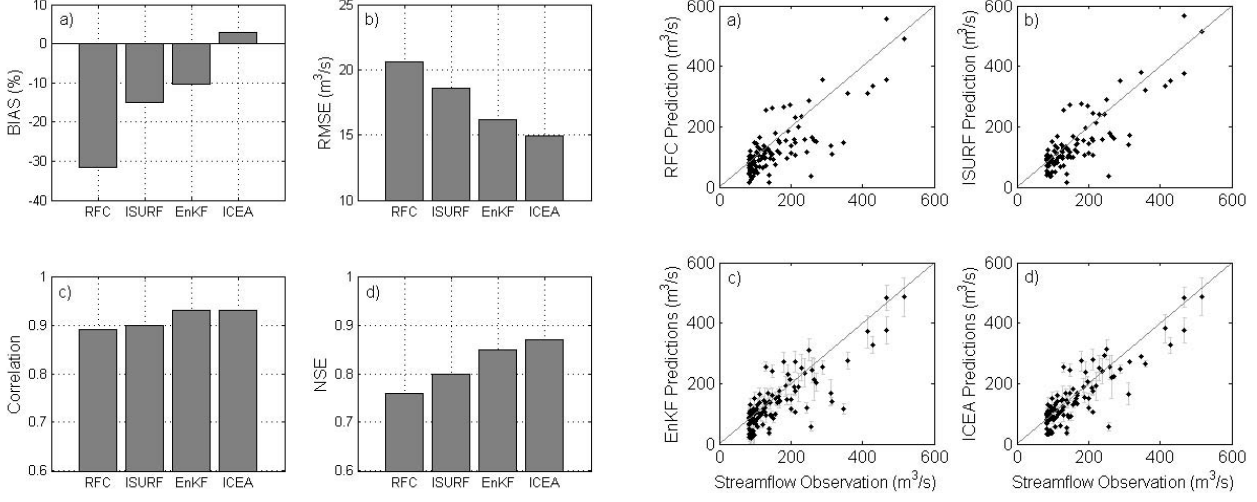
Fig. 7. Statistics between observed and predicted streamflow during Fig. 8. Scatter plot of predicted and observed high flows during the the prediction period (WY1991–1996) under four scenarios consid- prediction period under scenarios (a) RFC, (b) ISURF, (c) EnKF, ered for Bias (a) , RMSE (b) , Correlation (c) and NSE (d) . The and (d) ICEA. For the EnKF (c) and ICEA (d) scenarios, the entire ensemble-mean prediction is used in estimating statistics for the ensemble prediction ranges (error bars) are also shown except for EnKF and ICEA scenarios. the ensemble mean prediction Table 5. Statistics for observed and predicted high flows (above the 95th percentile of observed streamflow) during the prediction period. The EnKF and ICEA statistics are based on the ensemble mean predictions. RFC ISURF EnKF ICEA R 0.80 0.85 0.83 0.87 Bias (%) − 19.58